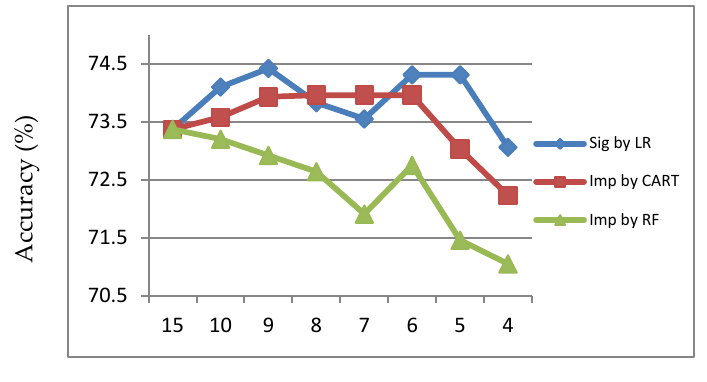
Figure 11. Accuracy of CART with input of significant or important variables.